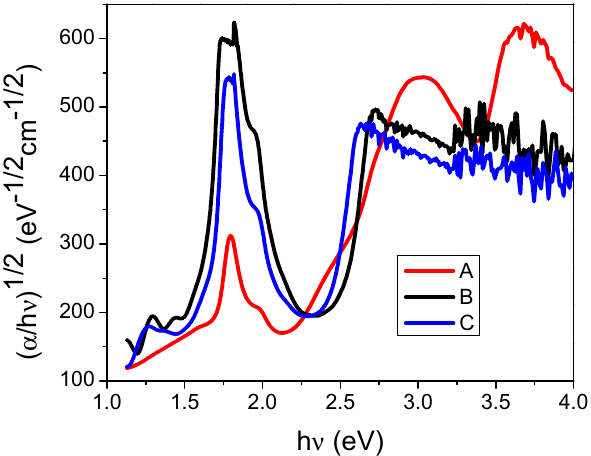
Figure 4. Plot of ( α / h ν ) 1/2 vs. photon energy h ν of thin Films A , B and C deposited on Q-substrate.